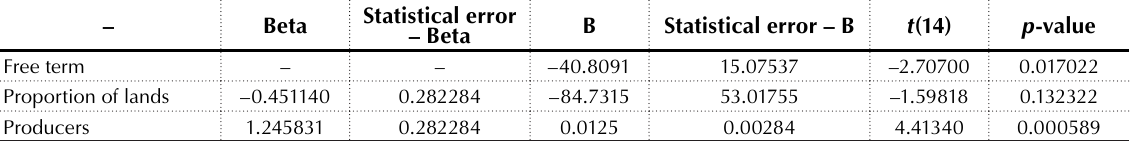
Table 4. Regression results for the dependent